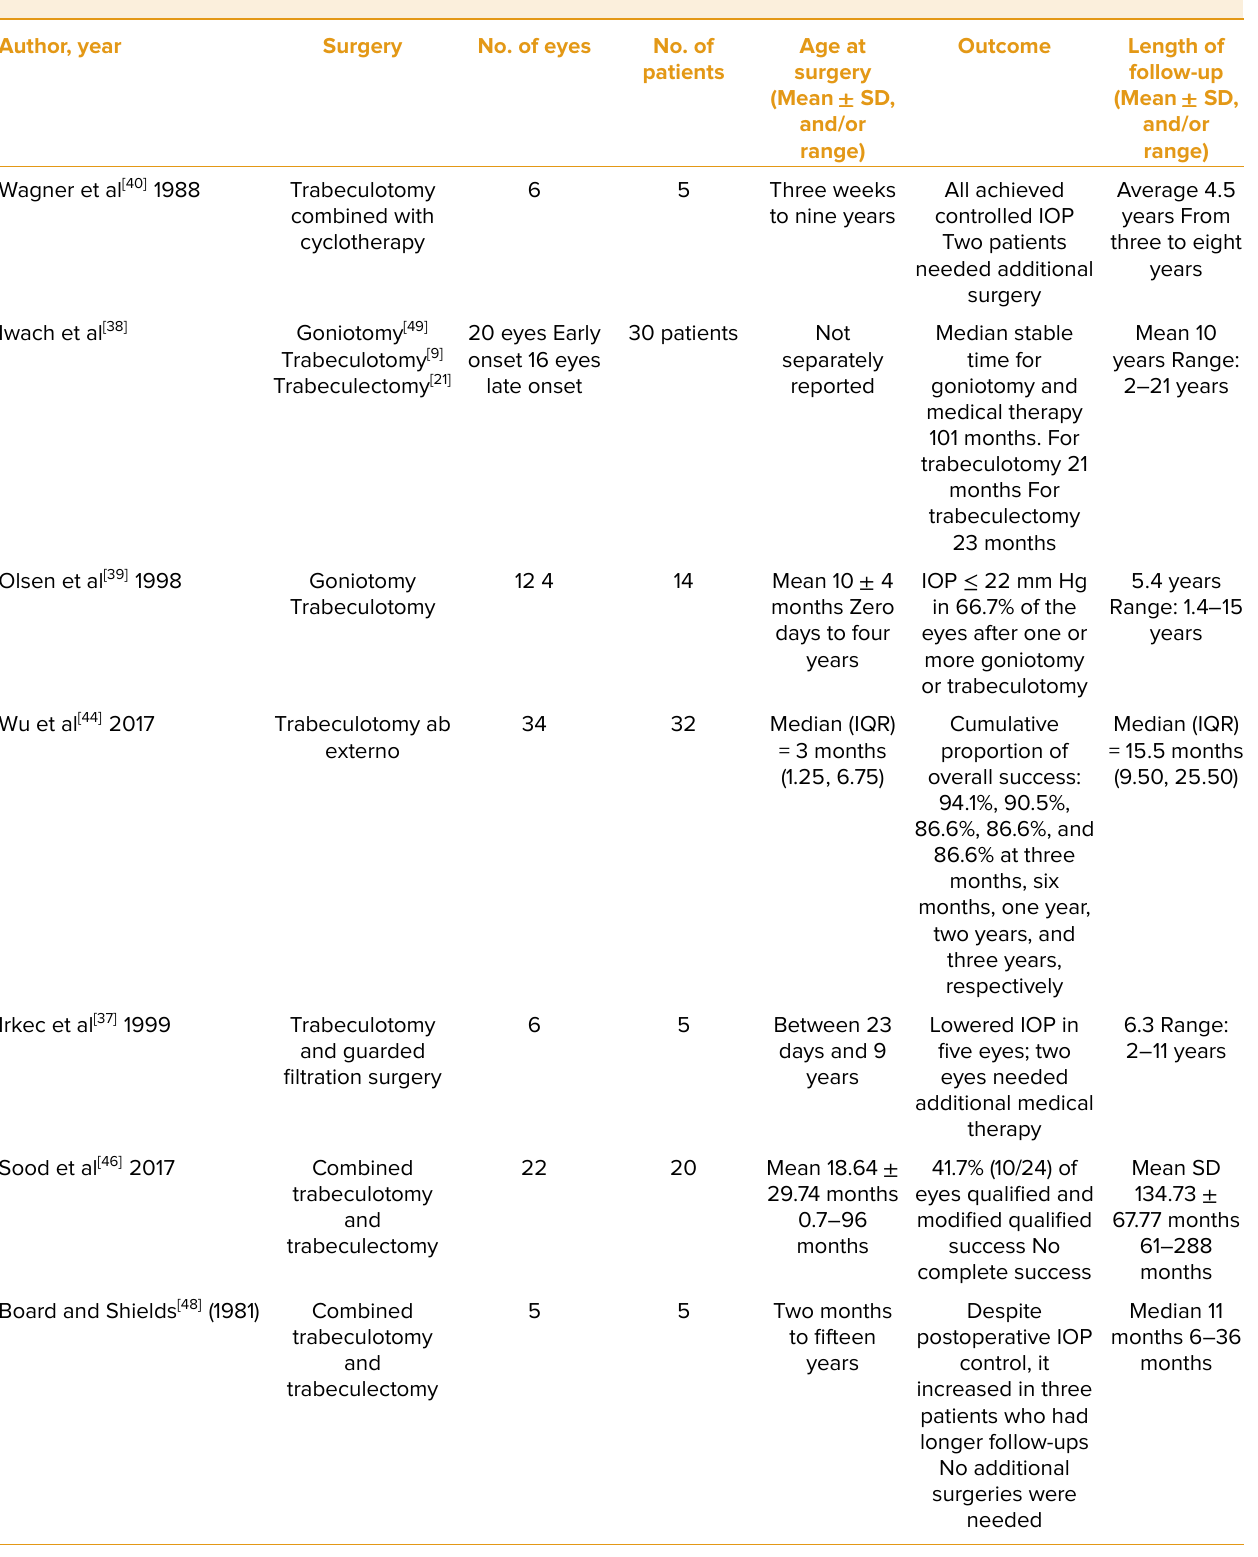
Table 2. Summary of important studies investigating different surgeries in the treatment of glaucoma associated with Sturge- Weber